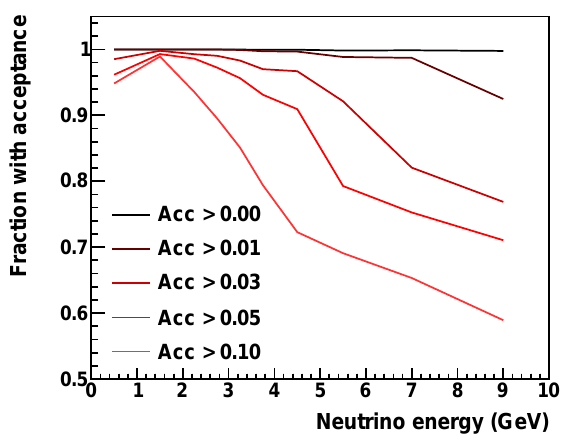
Figure 36. This figure summarizes the neutrino acceptance in the ( q 3 , q 0 ) plane, as shown in Figure 35, for all bins of neutrino energy. Here the quantity on the vertical axis is the fraction of events that come from bins in ( q 3 , q 0 ) with an acceptance greater than A cc . As an example we consider the 3.5GeV to 4.0GeV neutrino energy bin. The A cc > 0.1 curve in that neutrino energy bin indicates that 80% of events come from ( q 3 , q 0 ) bins that have an acceptance greater than 10%. The A cc > 0.00 curve shows there are no acceptance